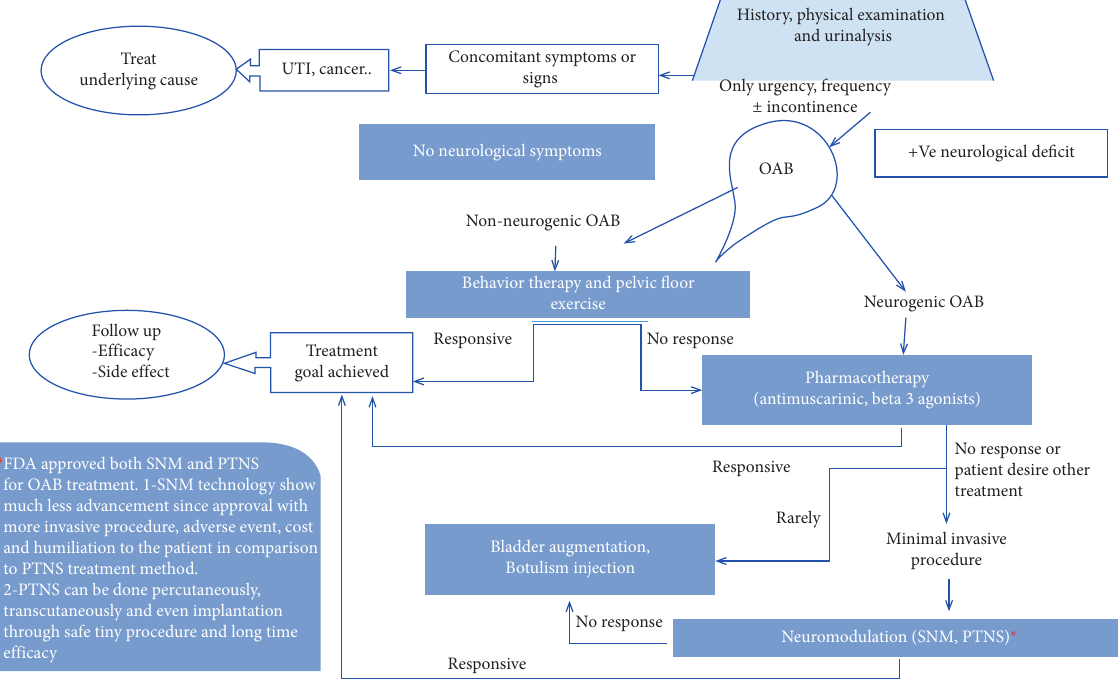
Figure 3: Diagram illustrating diagnosis of overactive bladder syndrome and role of posterior tibial nerve stimulation in its management. OAB: overactive bladder, UTI: urinary tract infection, SNM: sacral neuromodulation, PTNS: posterior tibial nerve stimulation, and FDA: Food and Drug